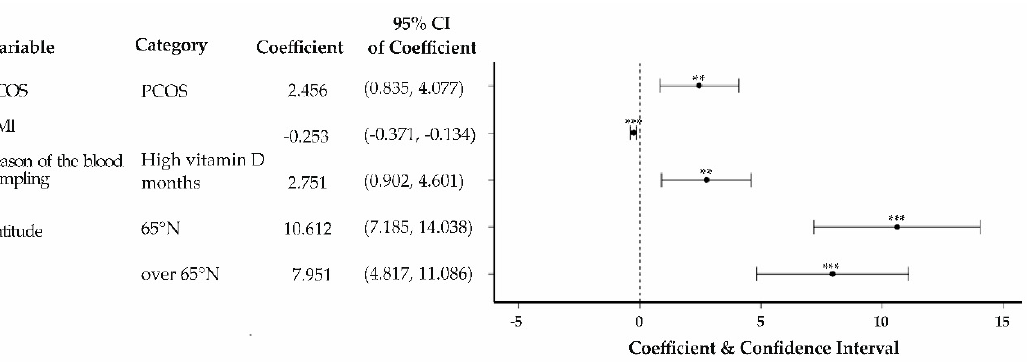
Figure 2. Associations of 25-hydroxyvitamin D (25(OH)D) levels and PCOS with relevant exposures in linear regression model. The model was adjusted with BMI, season of the blood sampling, latitude, and vitamin D laboratory batch effect. The reference classes for categorized variables were as follows: PCOS = controls; BMI as a continuous variable; season of the blood sampling = low vitamin D months; latitude = 60° N. *** p < 0.001, ** p < 0.01. 60° N = Helsinki and surrounding areas, 65° N = the city of Oulu, and >65°N = the northernmost provinces of Oulu and Lapland; PCOS = polycystic ovary syndrome; BMI = body mass index; N = north; CI = confidence interval.